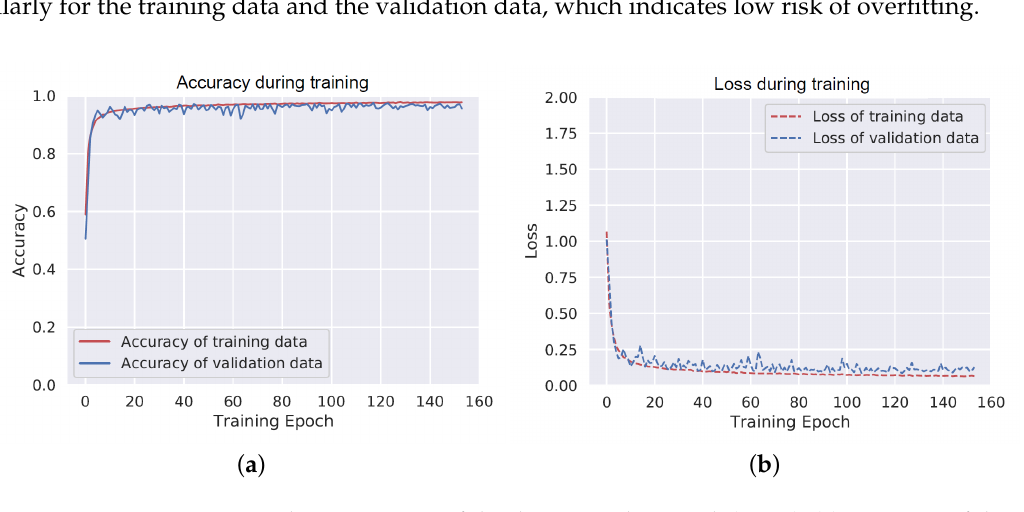
Figure 3. Learning curves during training of the deep neural network (DNN). ( a ) Accuracy of the training and validation data, ( b ) loss of the training and validation